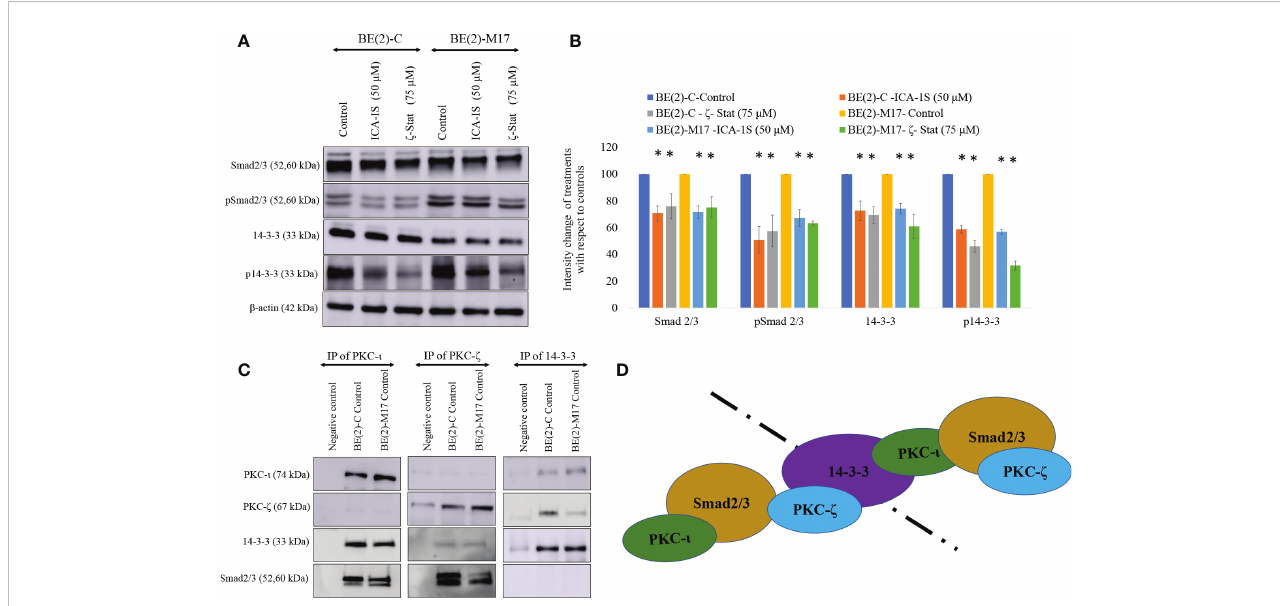
FIGURE 5 PKC- i and PKC- z bind with 14-3-3 and Smad2/3. (A) Western blots of the expression of the protein levels of Smad2/3, phosphorylated Smad2/3, 14-3-3 and phosphorylated 14-3-3 for the inhibitor treatments (50 µM of ICA-1S and 75 m M of z -Stat). Protein (60-80 µg) was loaded into each well and b -actin was used as the housekeeping marker in each Western blot. (B) Densitometry values for Western blots in A) in which experiments ( N = 3) were performed and representative bands are shown. Graphs depict percentage change of treated samples with respect to their controls and mean ± SD are plotted. (C) Whole cell lysates (100 µg) of BE(2)-C and BE(2)-M17 cells were immunoprecipitated separately for PKC- i , PKC- z and 14-3-3 using speci fi c beads. Western blots of PKC- i , PKC- z , 14-3-3 and Smad2/3 were obtained for the immunoprecipitated samples. Experiments ( N = 3) were performed. (D) Schematic representation of possible associations of the proteins as obtained from the data. Statistical signi fi cance is indicated by asterisk as * P <